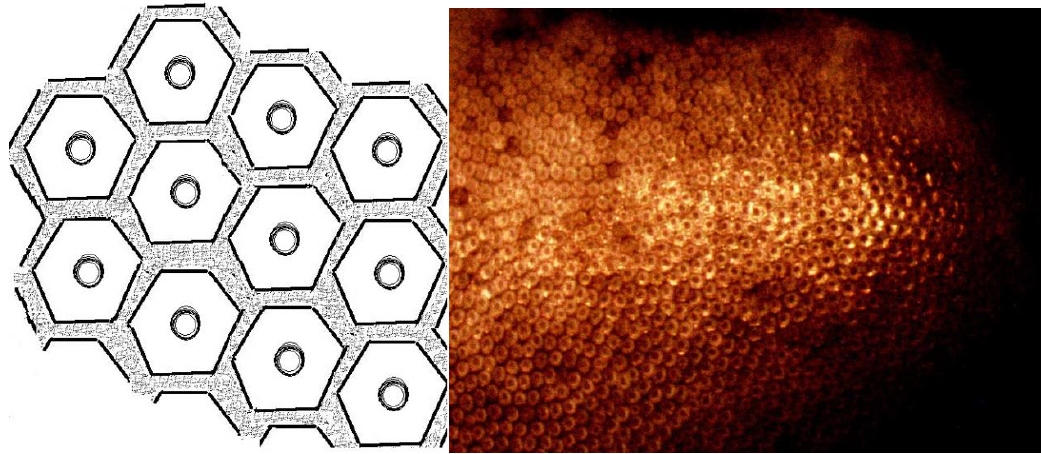
Рис. 3. Хорион яйца кузнечика Damalacantha vacca (рисунок и общий вид под